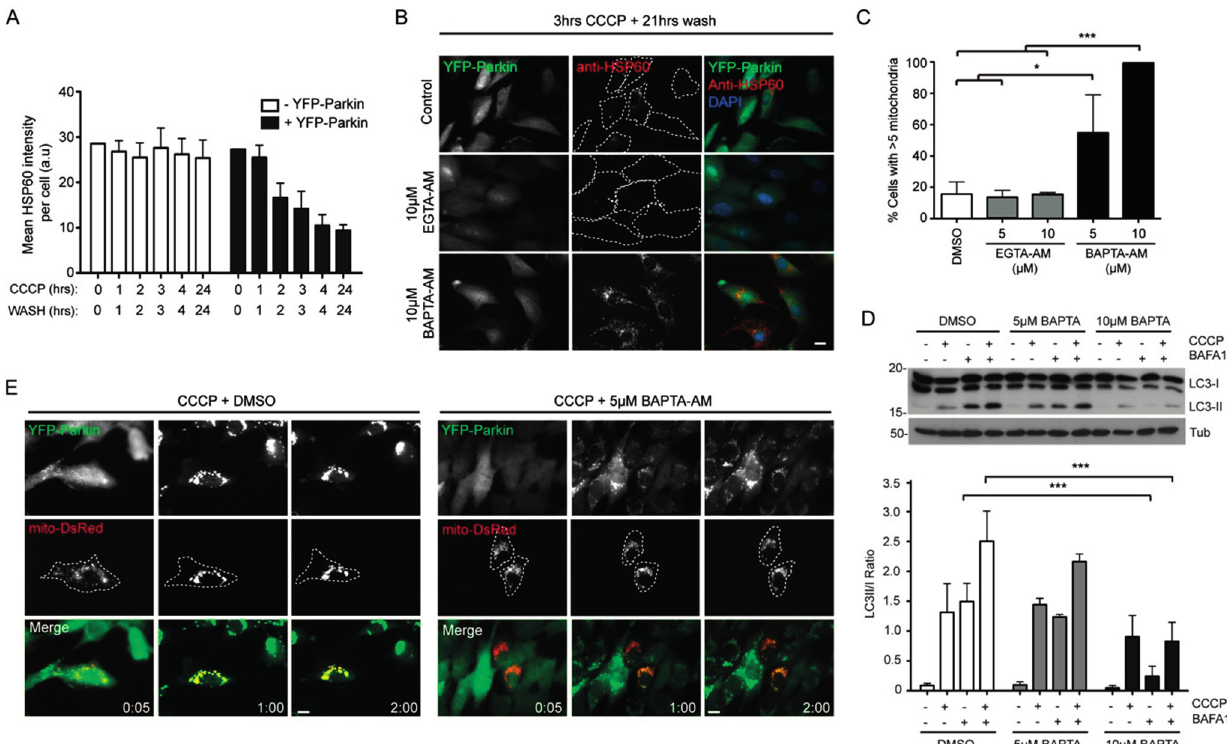
Figure 5. BAPTA-AM blocks mitophagy in YFP-Parkin RPE1 cells. ( A ) Establishing the shortest CCCP treatment for a robust mitophagy response; ( B ) Example images of mitochondrial content in YFP-Parkin RPE1 cells treated with CCCP in the absence or presence of 10 µM EGTA-AM or BAPTA-AM, followed by a 21-h wash; ( C ) Quantitation of mitophagy in cells treated with EGTA-AM or BAPTA-AM using the same treatment-chase procedure (3-h treatment; 21-h wash); ( D ) Measurement of the autophagy (LC3 lipidation) response in cells treated with 5 µM or 10 µM BAPTA-AM in the absence or presence of CCCP; ( E ) Live cell imaging of YFP-Parkin recruitment in RPE1 cells transfected with Mito-dsRed in the absence or presence of 5 µM BAPTA-AM, treated with CCCP. * p < 0.05; *** p < 0.001 one-way ANOVA, Tukey’s post -test. Scale bars = 10 µm.